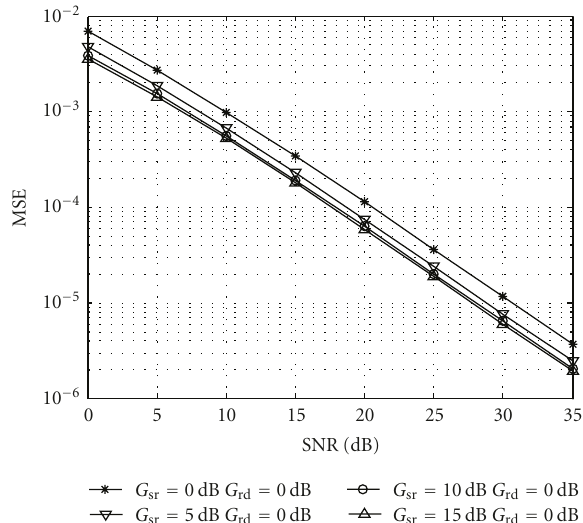
Figure 2: Impact of geometric gains on the MSE